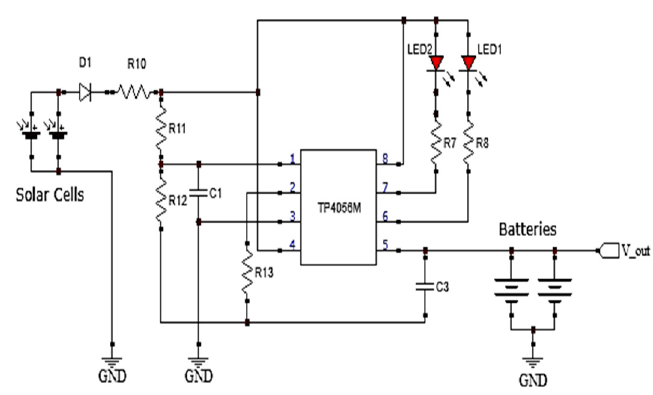
Figure 4. The user interface: ( a ) situations of compliance; ( b ) situations of error in data storage.